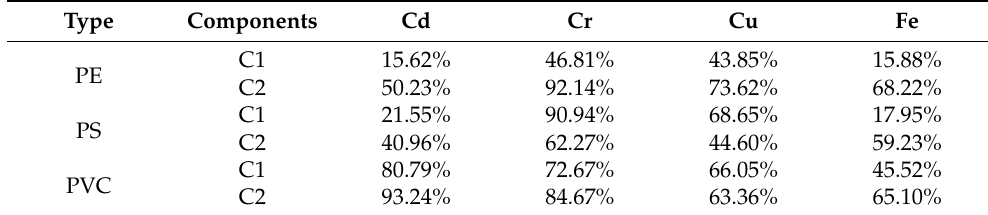
Figure 5. Changes in the fluorescent scores of the individual components of PE-DOM ( a , d ), PS-DOM ( b , e ), and PVC-DOM ( c , f ) with increasing metal concentrations (from 5 to 200 μM). Table 1. Abatement ratio of two individual components of MP-DOM after fluorescence quenching with 4 kinds of metal (200 μM).